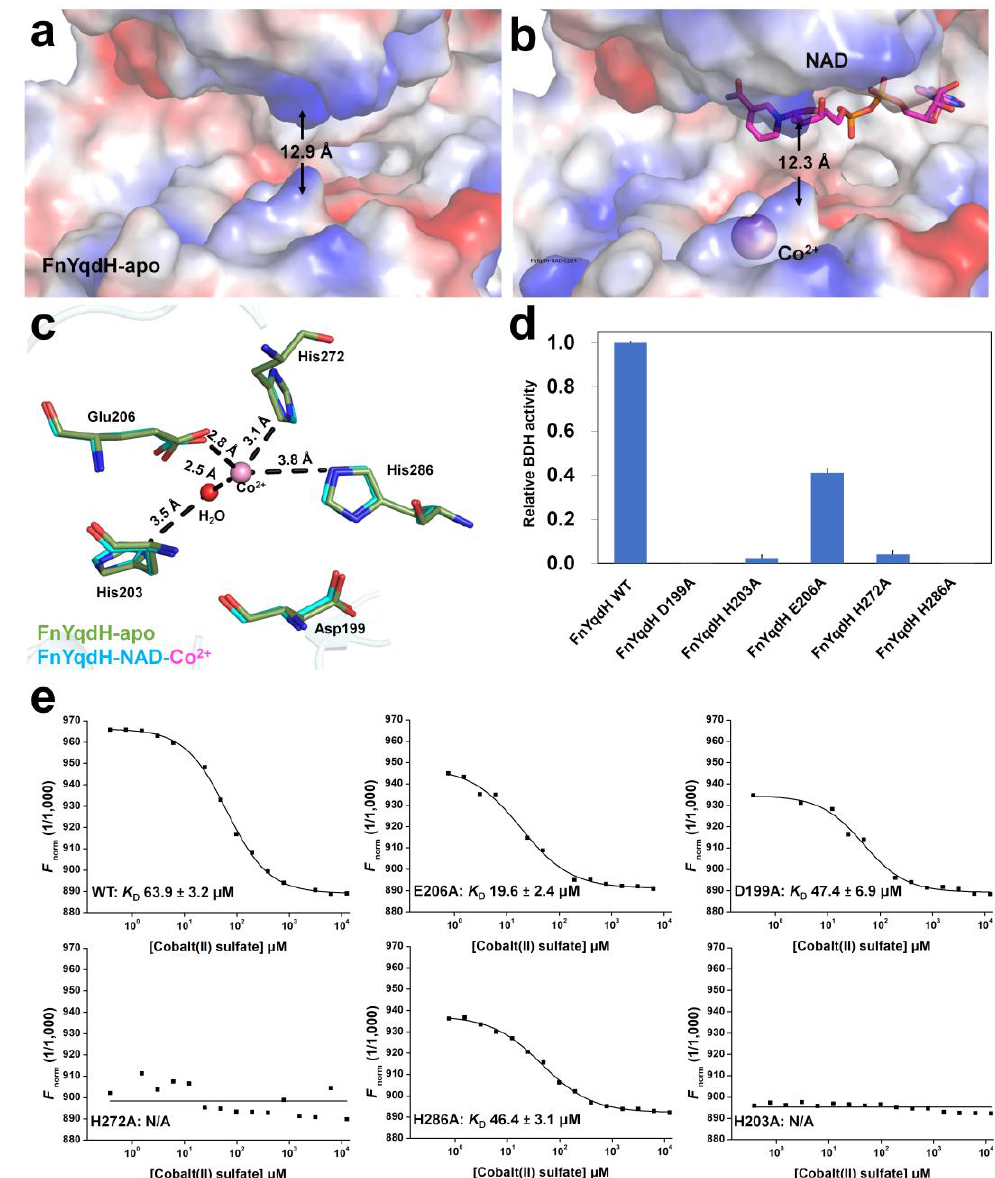
Figure 5. The metal-binding site of FnYqdH. The surface structure of substrate-binding cleft of ( a ) FnYqdH-apo and ( b ) FnYqdH-NAD-Co 2+ . ( c ) Superposition of the Co 2+ -binding site of FnYqdH (green) and FnYqdH-NAD-Co 2+ (cyan). ( d ) BDH activity of FnYqdH with mutated metal-binding residues (FnYqdH-D199A, FnYqdH-H203A, FnYqdH-E206A, FnYqdH-H272A, and FnYqdH-H286A). The activity of FnYqdH-WT was defined as 100%. ( e ) MST assays of the Co 2+ -binding affinity of FnYqdH-WT and its mutants (FnYqdH-D199A, FnYqdH-H203A, FnYqdH-E206A, FnYqdH-H272A, and FnYqdH-H286A). No Co 2+ -binding affinity of FnYqdH-H203A and FnYqdH-H272A was detected. K D values 63.9 μM, 19.6 μM, 47.4 μM , and 46.4 μM for Co 2+ , FnYqdH-WT, FnYqdH-E206A, FnYqdH-D199A, and FnYqdH-H286A, respectively.